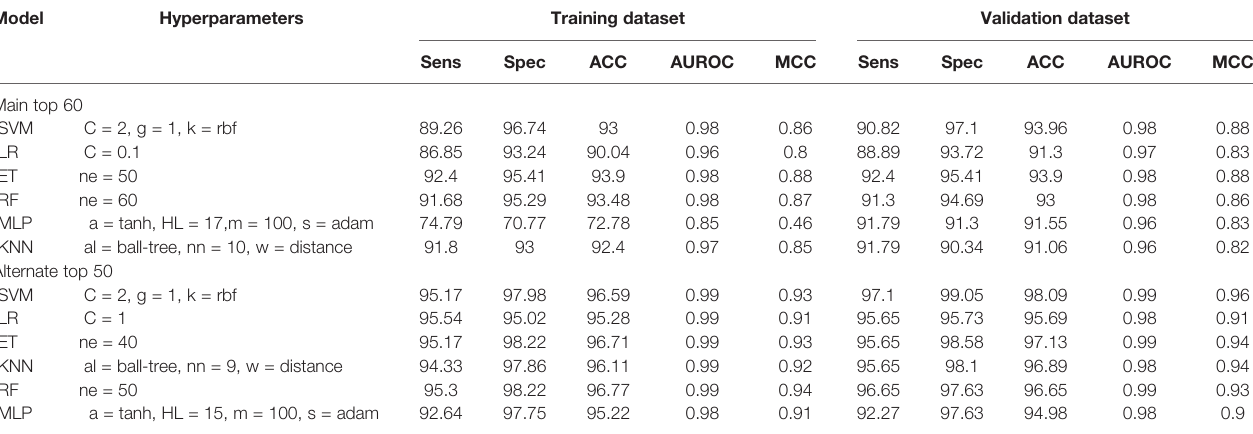
TABLE 2 | The performance of machine learning models on top 60 features for main dataset and top 50 features for alternate dataset.